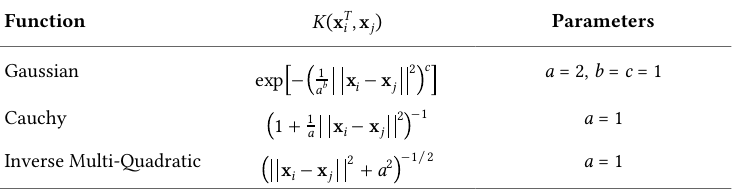
Kernel Functions